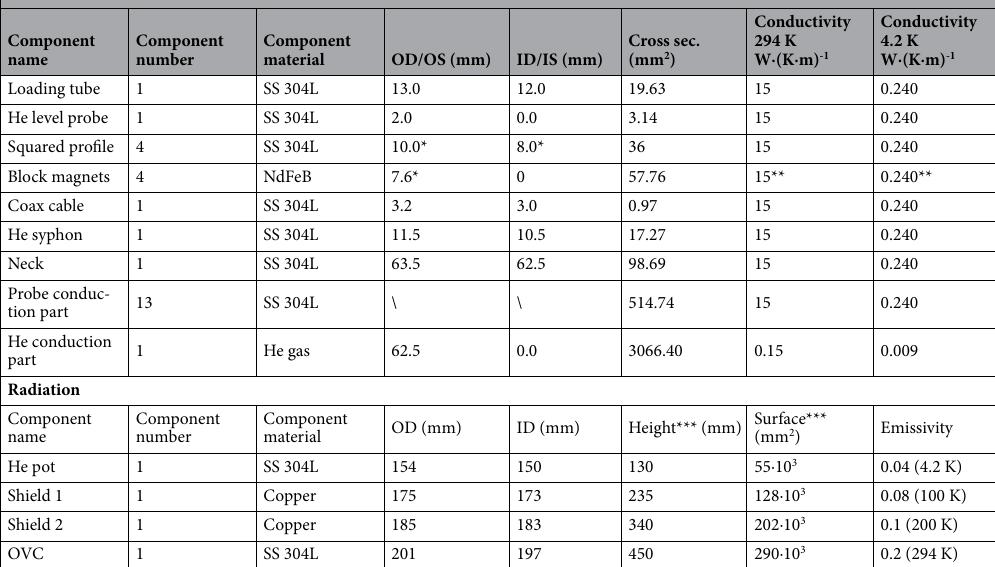
Table 1. All components, geometrical dimensions and parameters used in the model are listed here. We report only the thermal conductivity of stainless steel (SS 304L) and He gas at 294 K and 4.2 K as an example; its temperature dependence is derived into the MATLAB script (see Supporting Information, Figure S1). For the squared profile OS and IS represent its external and internal dimension and not diameter (*). The NdFeB thermal conductivity is assumed identical to SS 304L (**). Concerning the height and thus the surfaces of the different components, we report the values chosen to build the cryostat